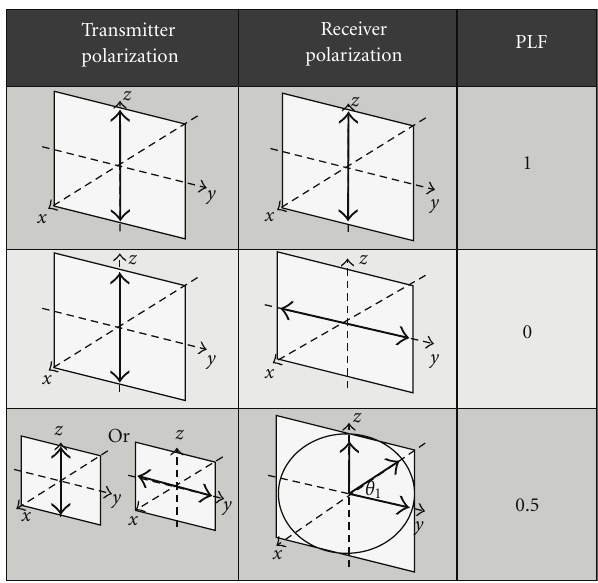
Figure 7: PLF according to di ff erent transmitter/receiver polariza-